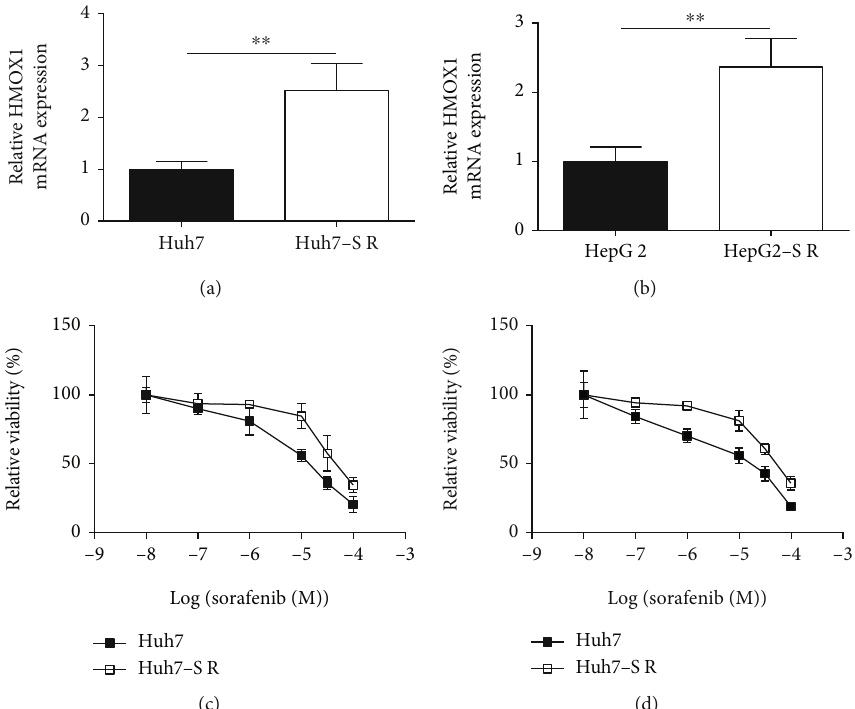
Figure 5: HMOX1 was upregulated in the sorafenib-resistant HCC cells. (a) The relative mRNA expression of HMOX1 in Huh7 and Hun7- SR cells. (b) The relative mRNA expression of HMOX1 in HepG2 and HepG2-SR cells. (c) MTT assay measured the relative viability of Huh7 and Huh7-SR cells. (d) MTT assay measured the relative viability of HepG2 and HepG2-SR cells. N = 3 . ∗∗ P < 0 : 01